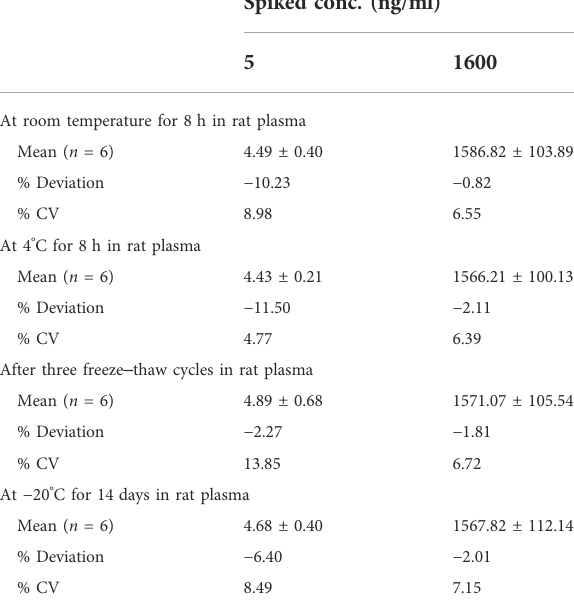
TABLE 3 Stability of glytrexate in rat plasma ( n =